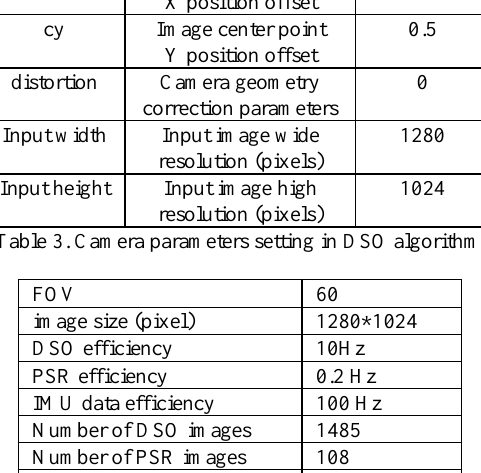
21 shows the position errors of the integrated navigation system.